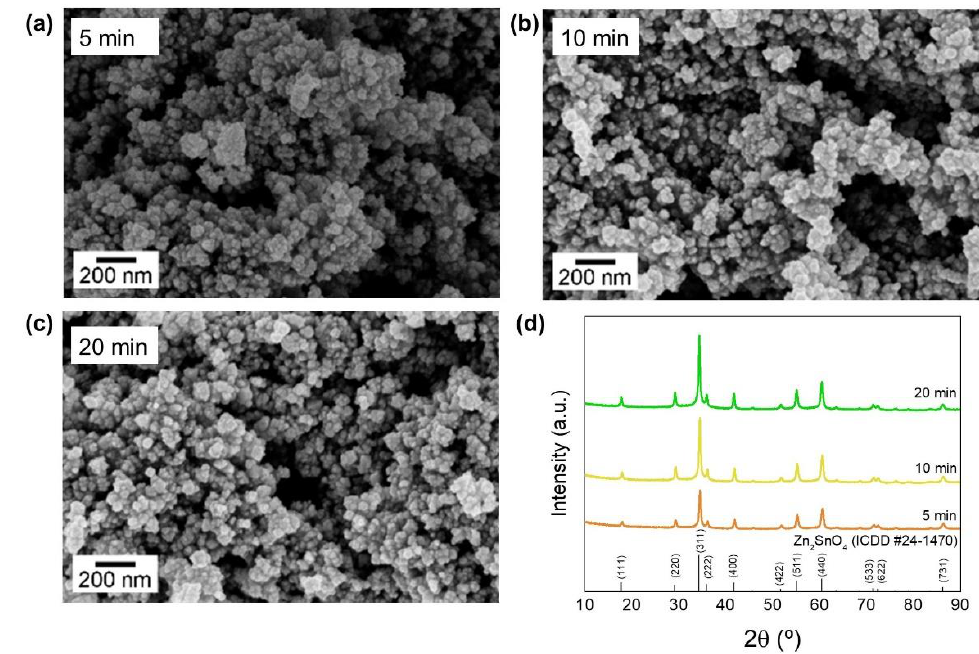
Figure 3. ( a – c ) SEM images and ( d ) XRD pattern of the Zn 2 SnO 4 nanoparticles synthesized by microwave-assisted synthesis for 5, 10 and 20 min.